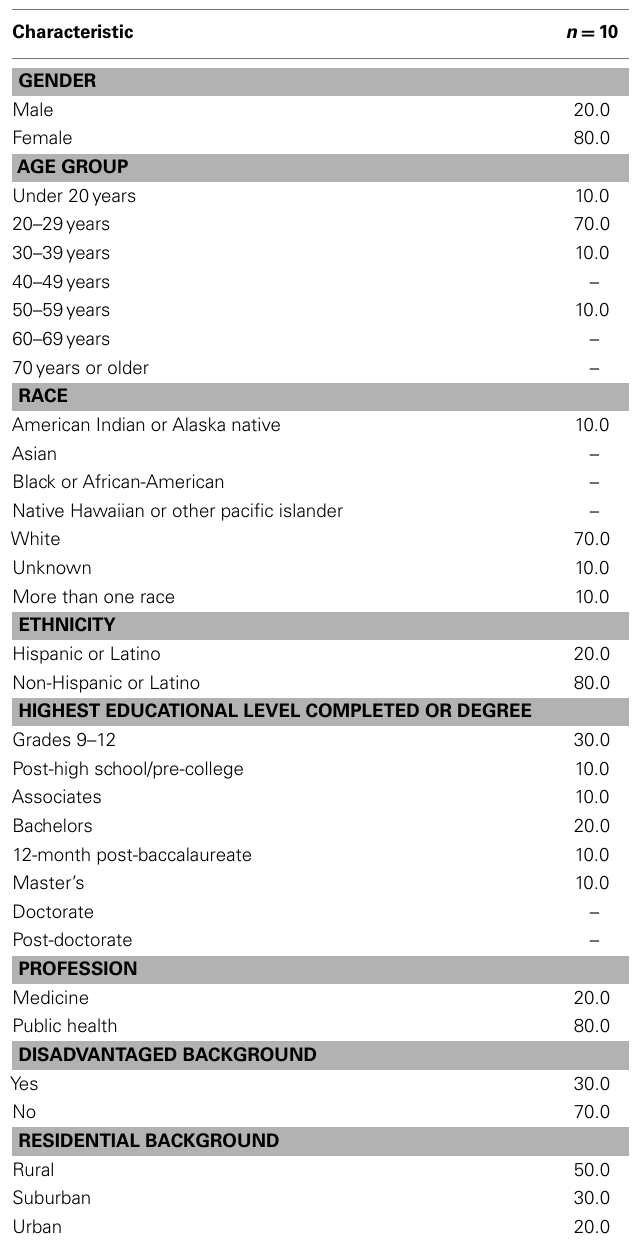
Table 1 | Demographics and participant background as a percentage of the sample